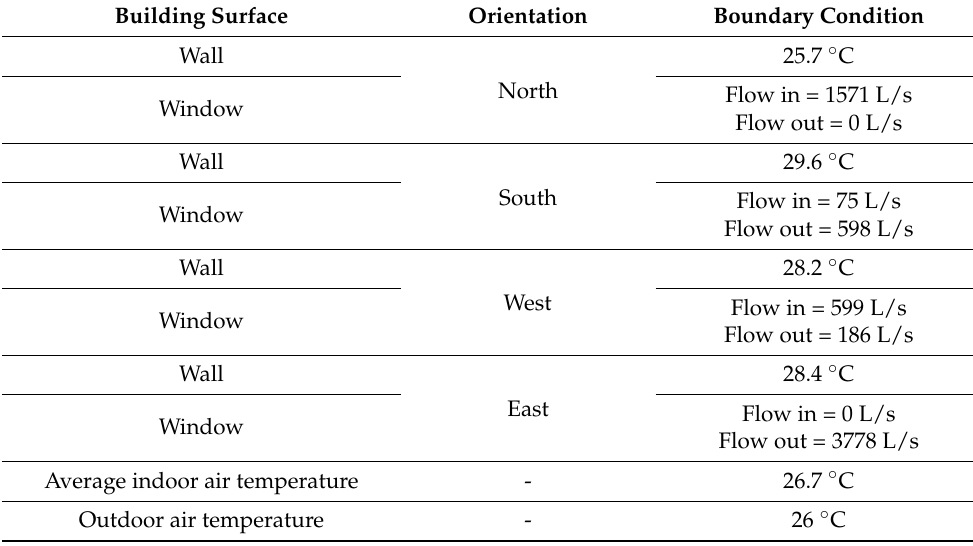
Table 3. Summary of the CFD boundary conditions of selected surfaces for each orientation of the building